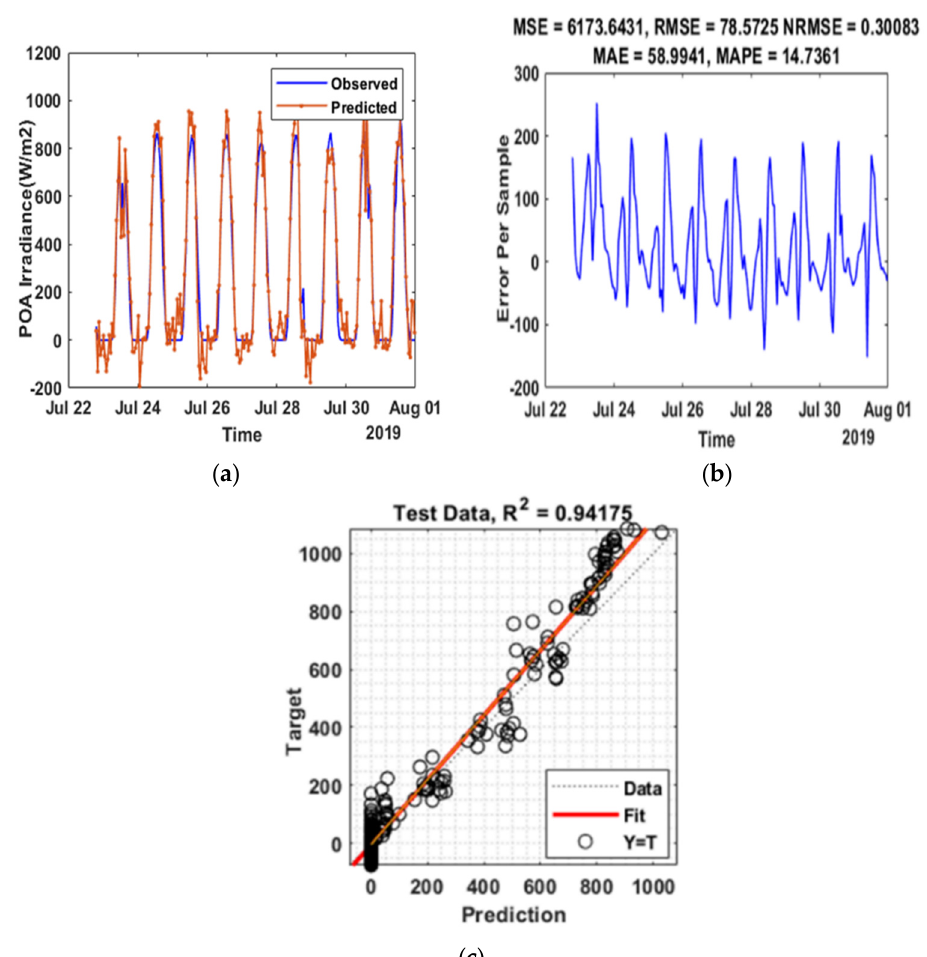
Figure 9. ( a ) The observed and predicted results, ( b ) error metrics and ( c ) regression plot considering POA-Sweihan photovoltaic independent power project, Abu Dhabi, for CNN.